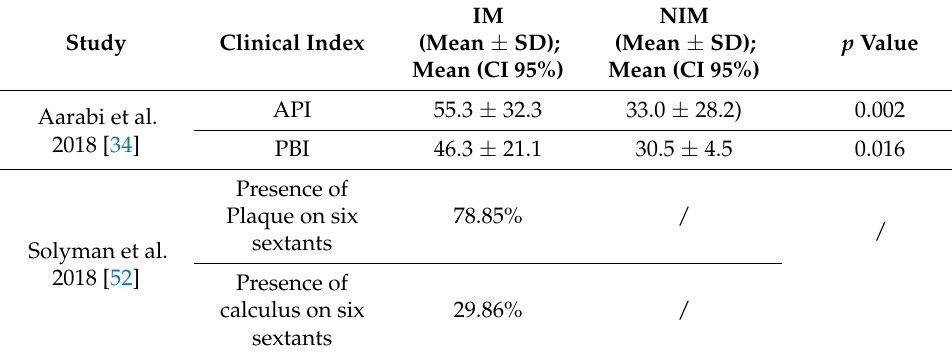
Table 12. Periodontal status in MI and NMI living in Germany.